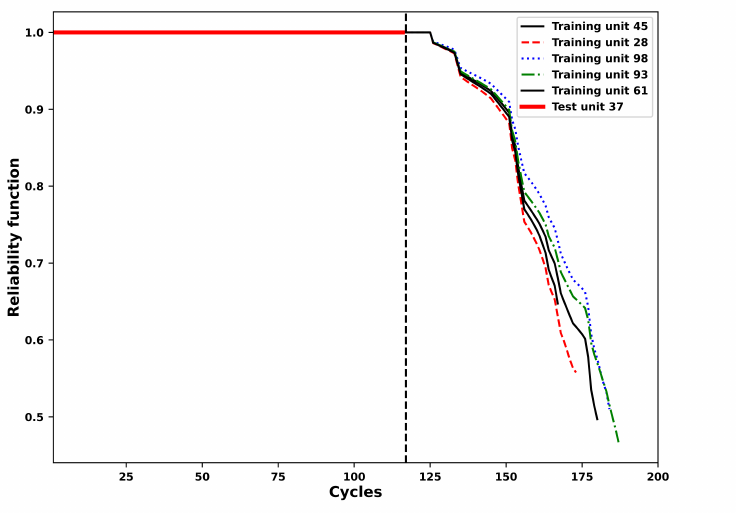
Figure 12. Predictions of the reliability function of the test set unit 37th considering its five most similar reliability indices of the training set